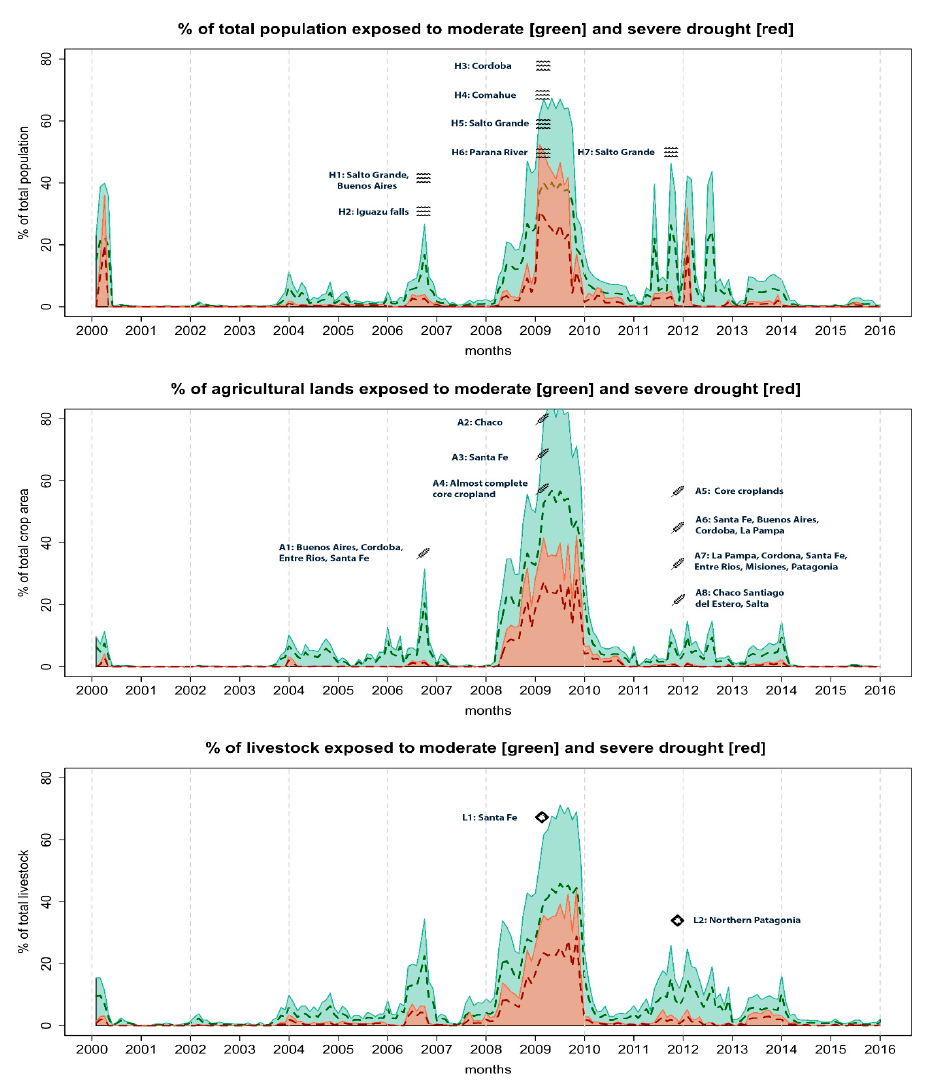
Figure 4. Percent of the total population exposed and hydrological impacts reported; croplands exposed and agricultural impacts reported; and livestock exposed and impacts on livestock reported (period 2000–2015). Dotted lines represent the exposed reduction due to adaptive capacity. Legend abbreviation refers to Appendix, Table A1.